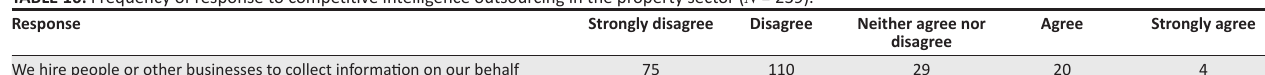
TABLE 16: Frequency of response to competitive intelligence outsourcing in the property sector ( N = 239). Response